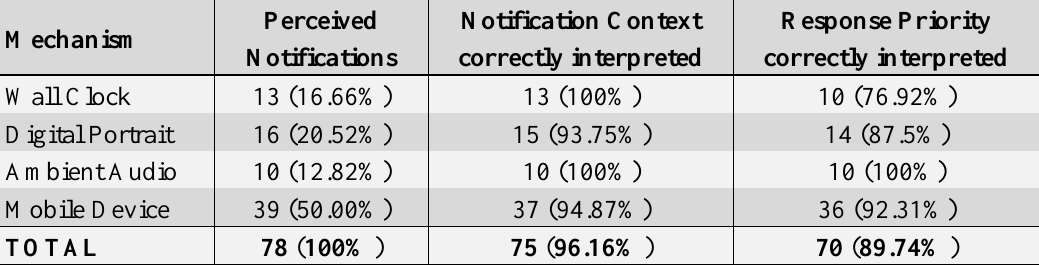
Table 2. Quantitative evaluation results for the CANoE-Aw